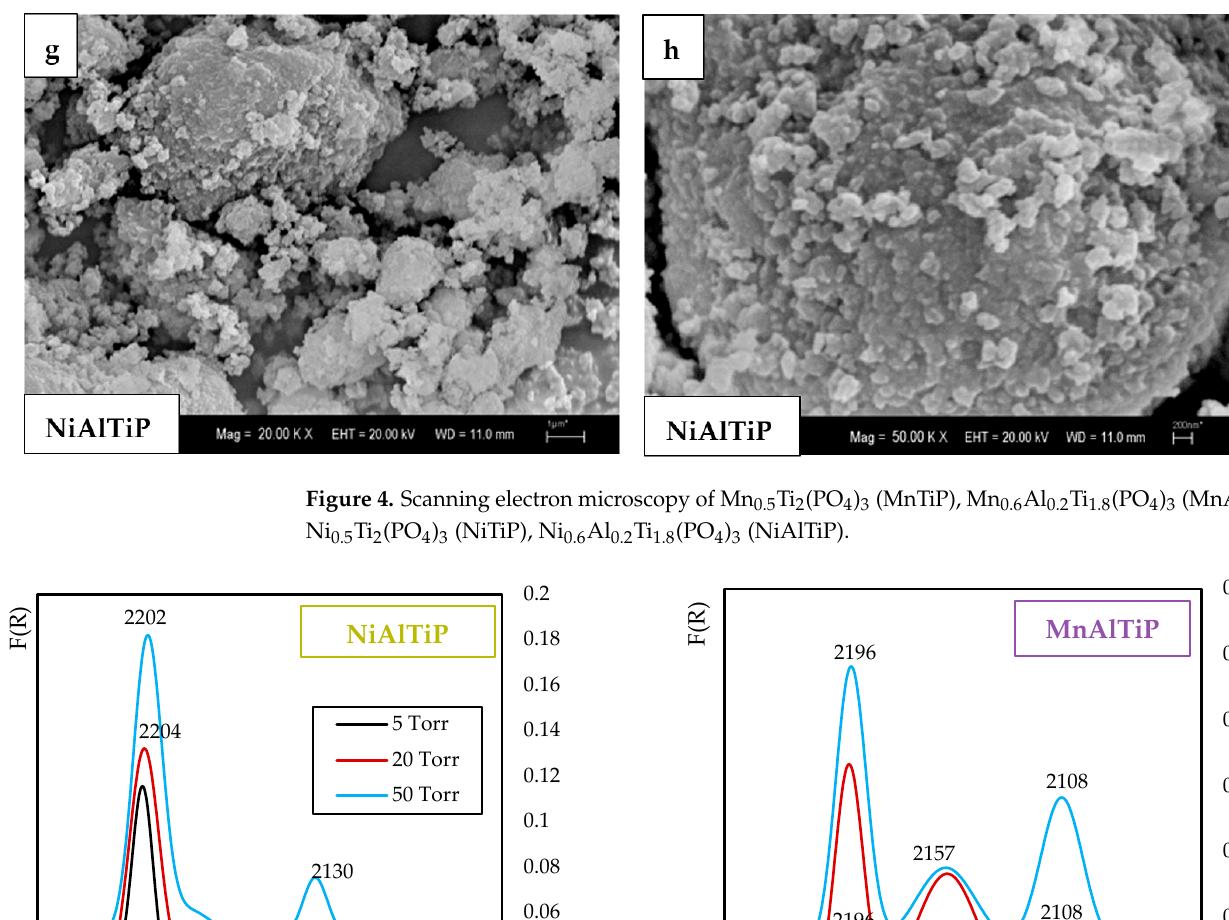
Figure 4. Scanning electron microscopy of Mn 0.5 Ti 2 (PO 4 ) 3 (MnTiP), Mn 0.6 Al 0.2 Ti 1.8 (PO 4 ) 3 (MnAlTiP), Ni 0.5 Ti 2 (PO 4 ) 3 (NiTiP), Ni 0.6 Al 0.2 Ti 1.8 (PO 4 ) 3 (NiAlTiP).